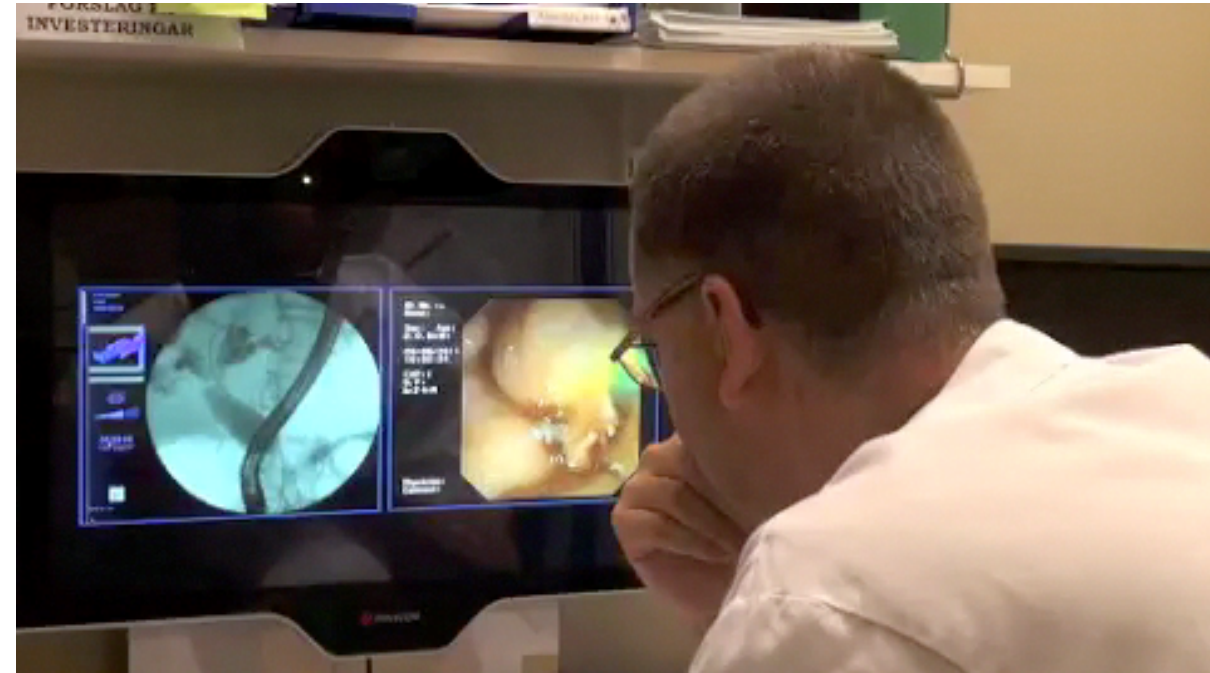
Figure 1. Teleguidance in endoscopic retrograde